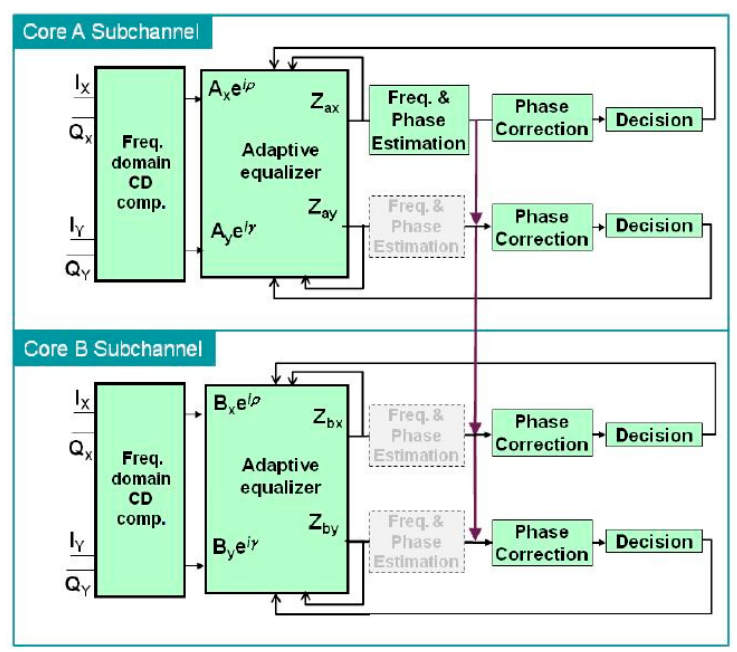
Figure 30. A joint DSP approach for multicore fiber (MCF)-based SDM transmission system with master–slave phase recovery [44].